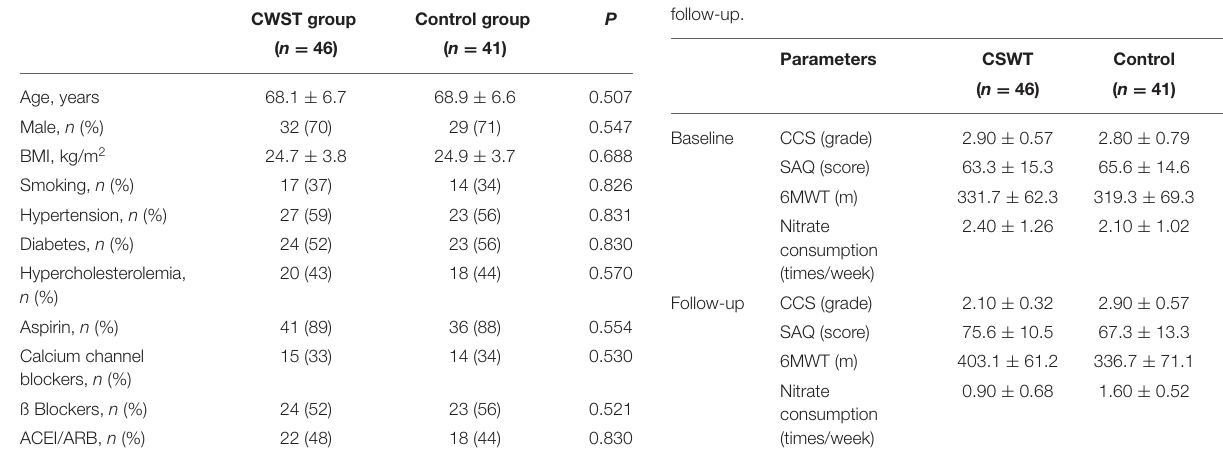
TABLE 2 | Biochemical parameters at baseline and follow-up.